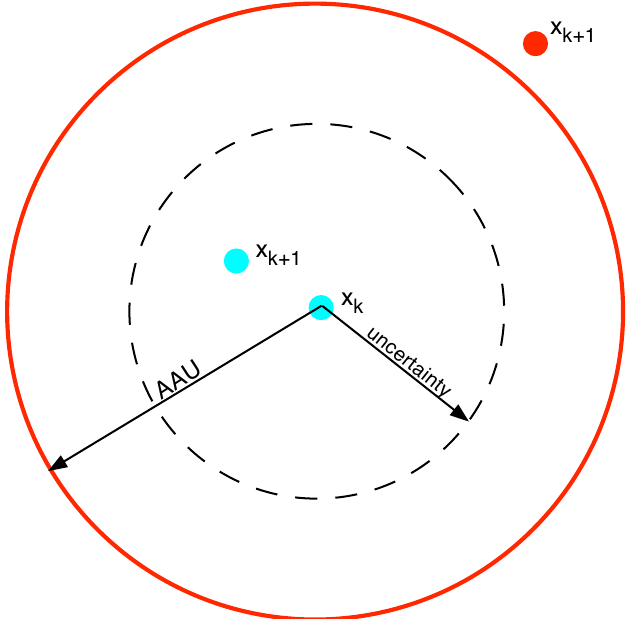
Figure 1. The growing uncertainty (dashed circle) and the maximum uncertainty bound (solid